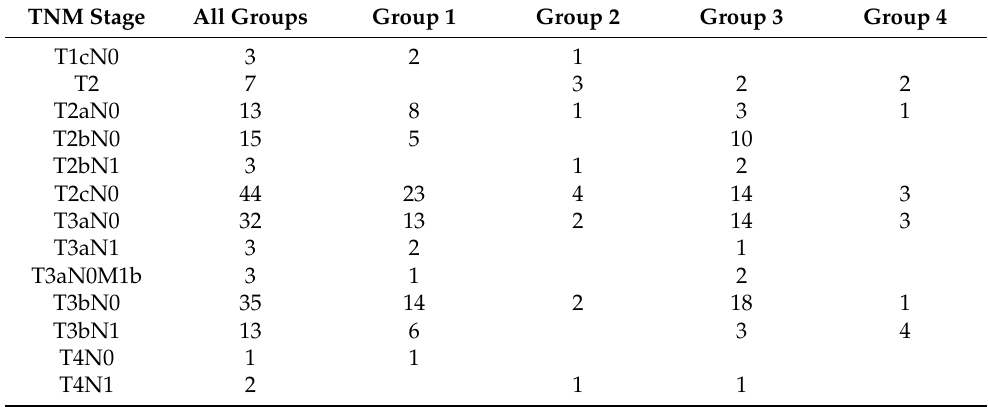
Table 2. Characteristics of TNM stage.